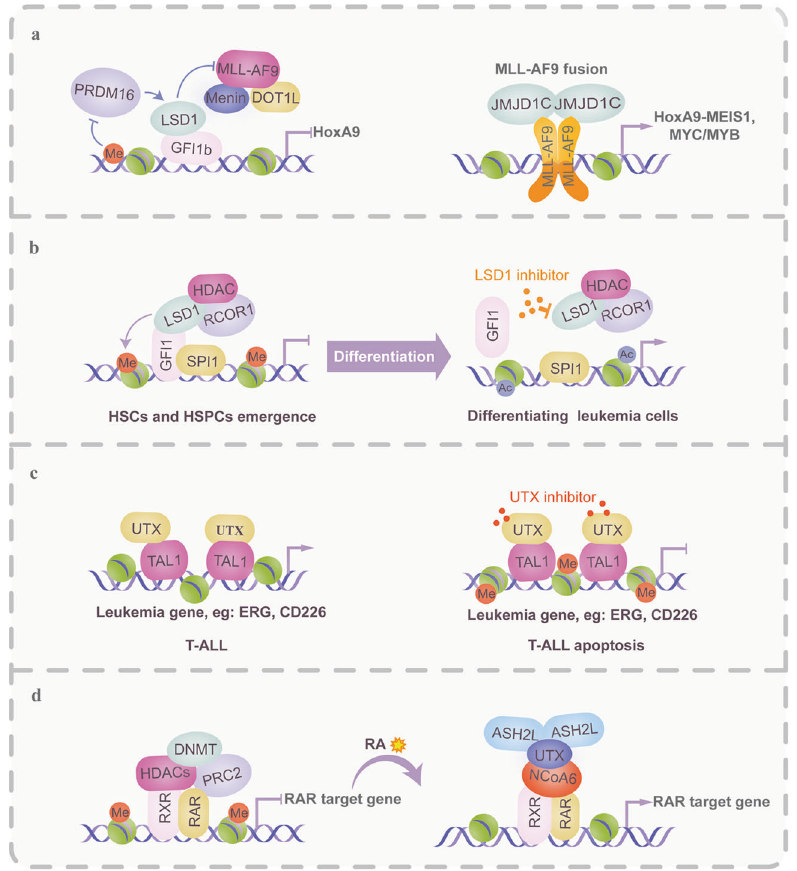
Fig. 5 HMT/HDT-based regulatory mechanisms in TCs are implicated in the pathogenesis and treatment of malignant hematopoiesis. HMTs and HDTs are recurrently mutated or aberrantly expressed in a variety of hematological malignancies. Their intrinsic activities on histone and nonhistone proteins within transcriptional complexes are critical for epigenetic control in normal and malignant hematopoiesis and are amenable to drug intervention or involved in drug therapeutic effects. a Left panel in mixed lineage leukemia (MLL)-AF9 fusion leukemia. MLL-AF9 recruits DOT1L, a histone 3 lysine 79 methyltransferase (H3K79me1/me2/me3), which leads to hematopoietic transformation via H3K79 dimethylation that causes aberrant transcription of genes such as HOXA9 and MEIS1. PRDM16 (a histone H3K4 methyltransferase), an antagonist to DOT1L, activates G fi 1b-mediated gene transcription, which in turn downregulates the HOXA gene cluster. However, PRDM16 expression is always silenced by DNA methylation in MLL-AF9 leukemia. Right panel, similar to DOT1L, the H3K9me2/me1 demethylase JMJD1C contributes to MLL-AF9 leukemia maintenance by affecting MYB, MYC, and HOXA9-MEIS1 gene expression programs, suggesting that individual genes can be regulated by different kinds of HMTs and/or HDT-containing TCs. b Growth factor independence 1 (GFI1) is critical to the initiation of the endothelial-to-hematopoietic transition (EHT) due to its recruitment of the LSD1 – CoREST repressive complex to epigenetically silence the endothelial program and allow the emergence of HSCs. Disruption or separation of the GFI1 – LSD1 repressive complex by LSD1 inhibitors is considered to induce differentiation in certain subtypes of AML. c UTX, a coactivator of TAL1, is essential to leukemia maintenance in TAL1-positive cells due to its promotion of an open chromatin con fi guration at target gene sites by H3K27me3 demethylation. A therapy based on UTX inhibition is ef fi cient at inducing cell death through downregulation of the TAL1 leukemic gene expression program. d UTX is a critical mediator of RA-induced differentiation in leukemic cells. RA treatment leads to the coordinated removal of repressive marks, the displacement of polycomb group proteins, and the deposition of activating marks. RA promotes the activation of RAR target genes by recruiting NCoA6, UTX, and ASH2L, concomitant with the demethylation of H3K27 and trimethylation of structure. 135 Speci fi cally, lineage-restricted deployment of the which erase methyl marks at the H3K4 and H3K9 residues. The JmjC family contains Fe(II)-dependent and α -ketoglutarate-depen- LSD1/CoREST complex controls hematopoietic differentiation. For dent dioxygenases, which can be further divided into groups with example, GFI1 recruits the LSD1/CoREST complex to epigenetically H3K4-, H3K9-, H3K27-, or H3K36-demethylating activities based on silence the endothelial program in the hemogenic endothelium the structure of the JmjC domain. and allow the generation of HSCs. 136 In erythropoiesis, the LSD1/ HDTs are extensively involved in hematopoietic differentiation, CoREST – BCL11A complex is required for full developmental ranging from embryonic to adult hematopoiesis, via HDT-TF silencing of mouse embryonic β -like globin genes and human γ - interplay. For example, the LSD1-mediated downregulation of the globin genes in adult erythroid cells. 137 etv2 gene in hemangioblasts is essential for the initiation of The TF-HDT interplay is multifaceted. As interacting cofactors, HDTs endothelial to hematopoietic transdifferentiation (EHT). 134 In generally act as coactivators of oncogenic TCs. For example, UTX is a coactivator of TAL1 and removes H3K27me at the TAL1 target locus, HSPCs, SALL4 dynamically controls the binding levels of LSD1 to allowing TAL1-mediated activation of a leukemic program. 138 JMJD1C hematopoietic regulatory genes, and LSD1 contributes to the repressive effects of SALL4 by affecting local chromatin functions as a coactivator for the AML1-ETO-containing AETFC